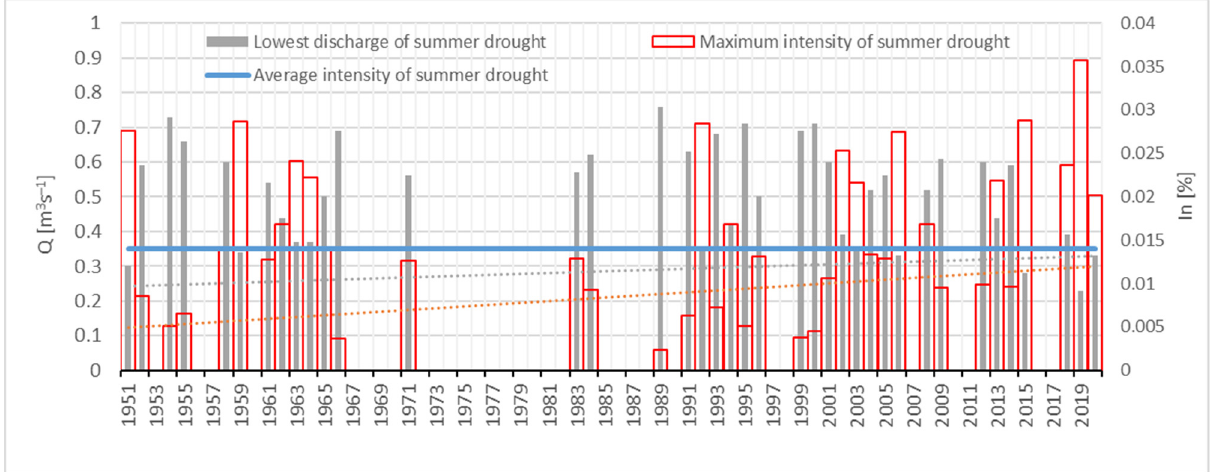
Figure 16. Maximum intensity of summer droughts and lowest discharge of summer droughts in the hydrological years 1951–2020 in the Narewka River to Narewka gauging profile.